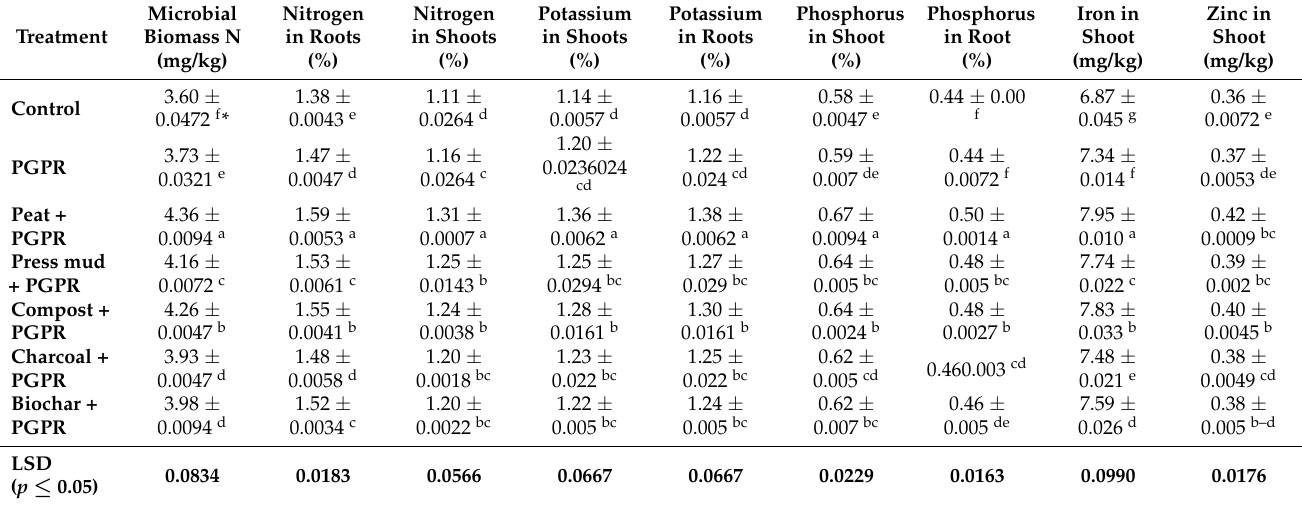
Table 6. Effect of different carrier materials on chemical parameters of okra in the field trial. Values are mean ± standard error of three replications.